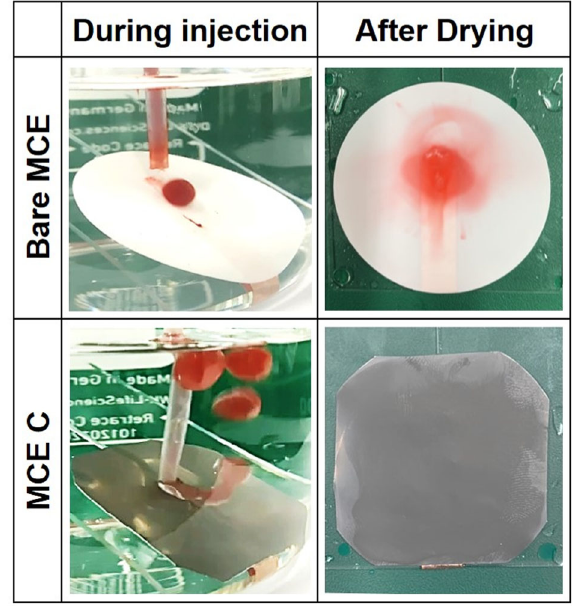
Fig. 8 Anti-oil adhesion capability. Photographs of bare MCE and coated MCE C during injection of toluene oil (dyed with Congo Red) and after